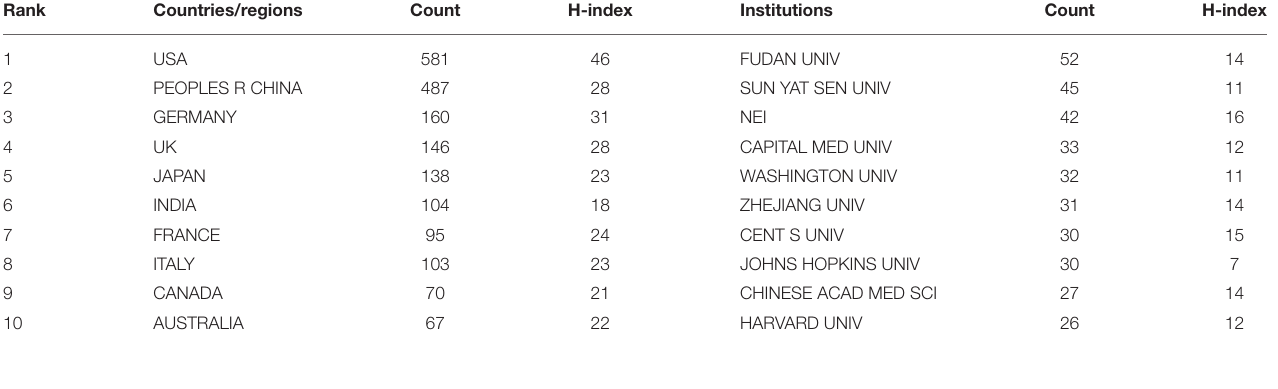
TABLE 1 | The top 10 Countries/Regions and Institutions to publications on Cataract-gene from 2010 to 2019. Rank